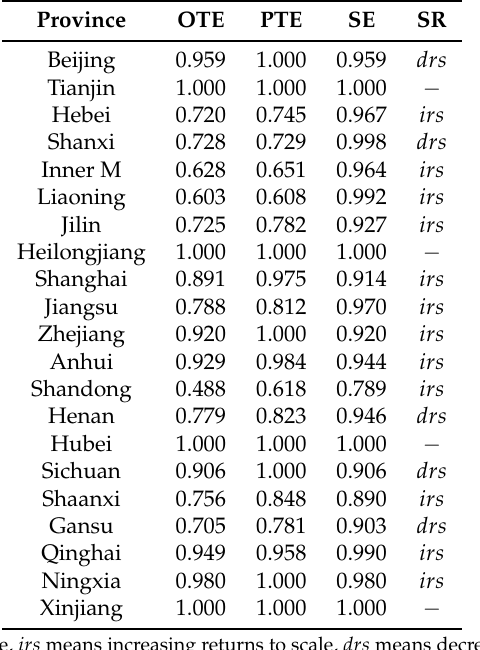
Table 2. The overall technical efficiency (OTE), pure technical efficiency (PTE), and scale efficiency (SE) of greenhouse